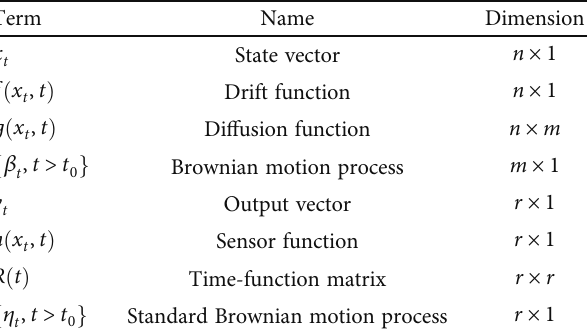
Table 1: Terms, their descriptions, and